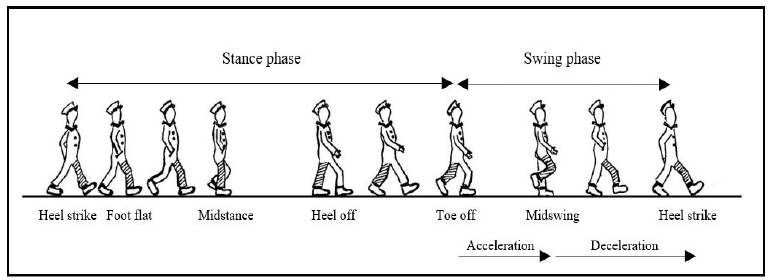
Figure 1. Different phases of gait movement adapted from [13]. Figure 1. Di ff erent phases of gait movement adapted from